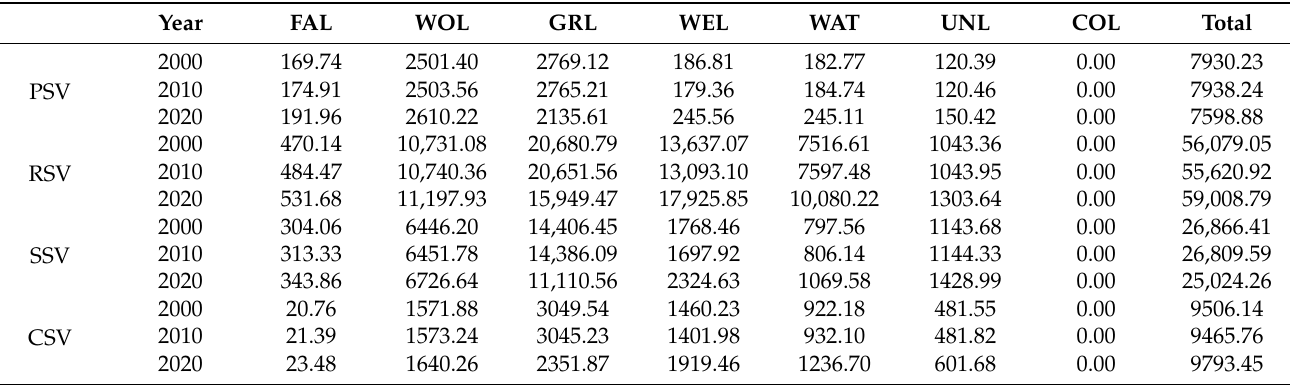
Table 2. Ecosystem services supply of land use types in nature reserves from 2000 to 2020 (USD millions).